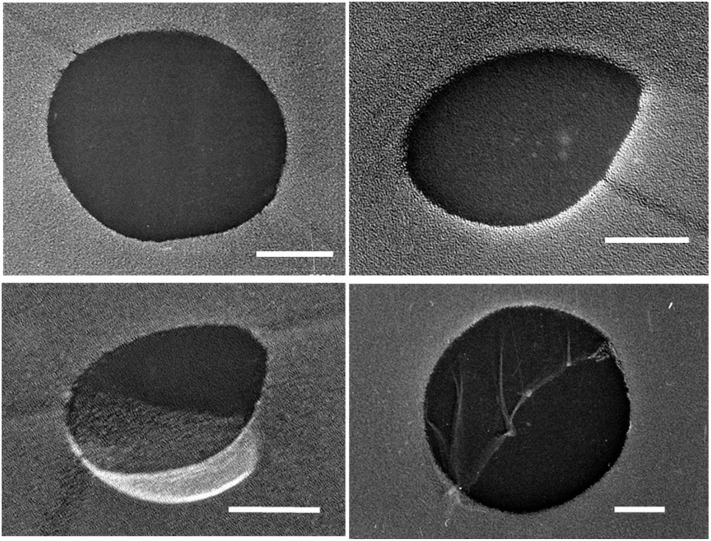
Typical TEM images of UFBs in C3H8-hydrate dissociation water by the freeze-fracture replica (FFT) method. Scale bars show 100 nm.